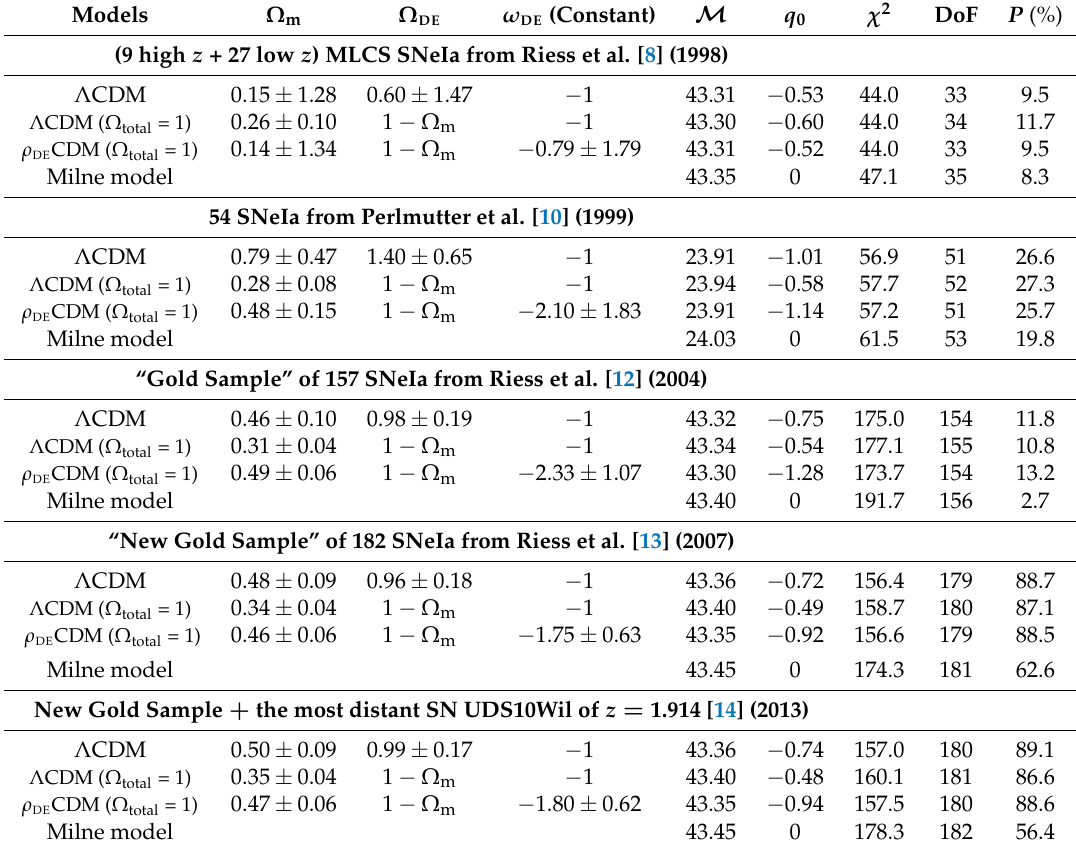
Table 1. Best-fit parameters of some selected cosmological models fitted to different SNeIa data sets.